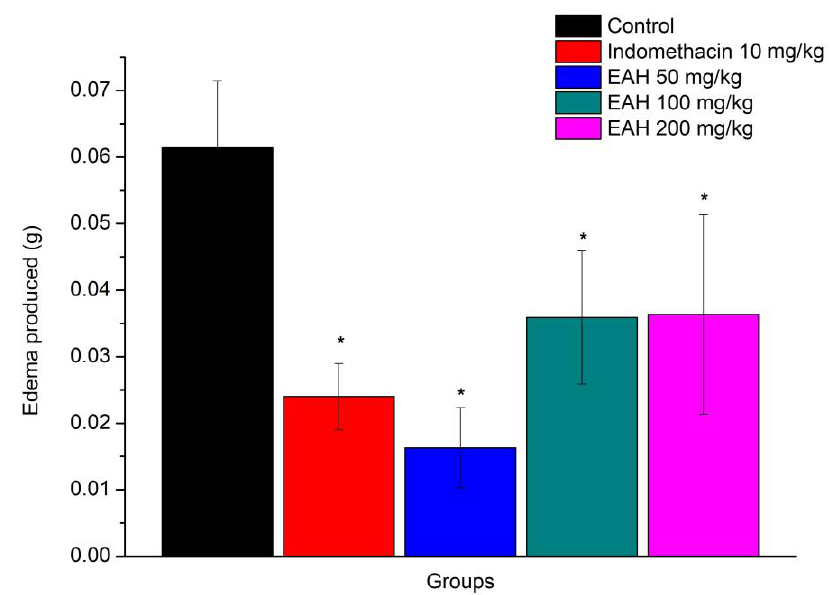
Figure 2. Average ( ± EPM) of the antiedematogenic activity of EAH at doses of 50, 100, and 200 mg/kg. The values shown in the graph represent the difference in weight between the left and right ear, * p < 0.05 when compared to the control group ( n = 5 for all groups). ANOVA followed by Duncan’s